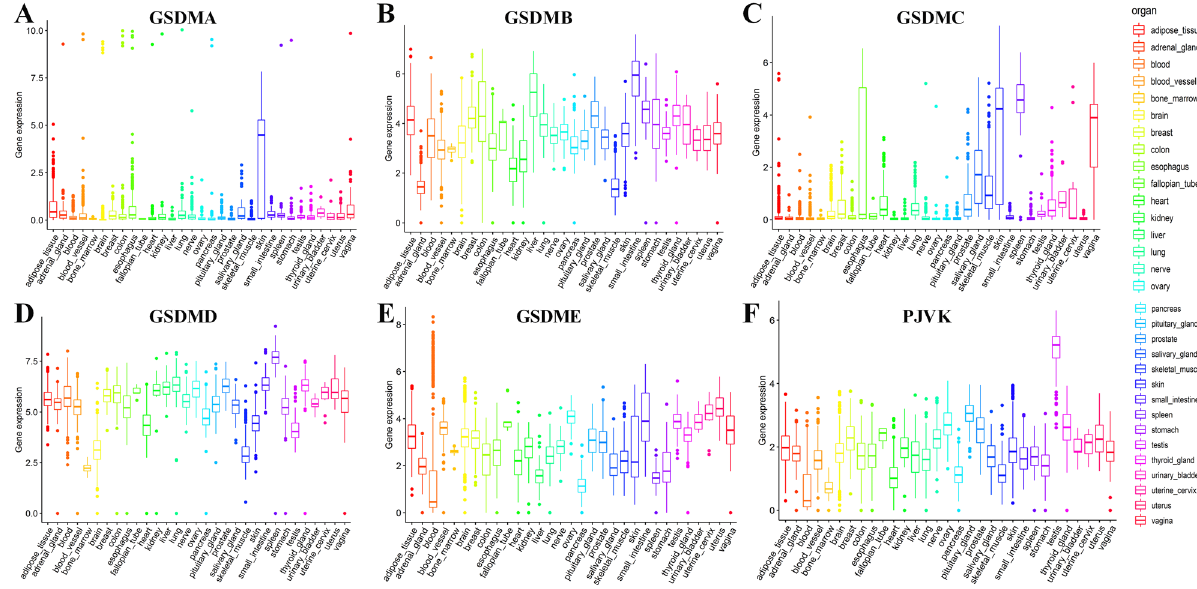
Figure 1. Expression levels of gasdermin family genes in normal tissues from the genotype-tissue expression (GTEx) database. GSDMA ( A ), GSDMB ( B ), GSDMC ( C ), GSDMD ( D ), GSDME ( E ), and PJVK ( F ). The Y axis represented the gene expression level, and the unit was log2 (TPM + 1).